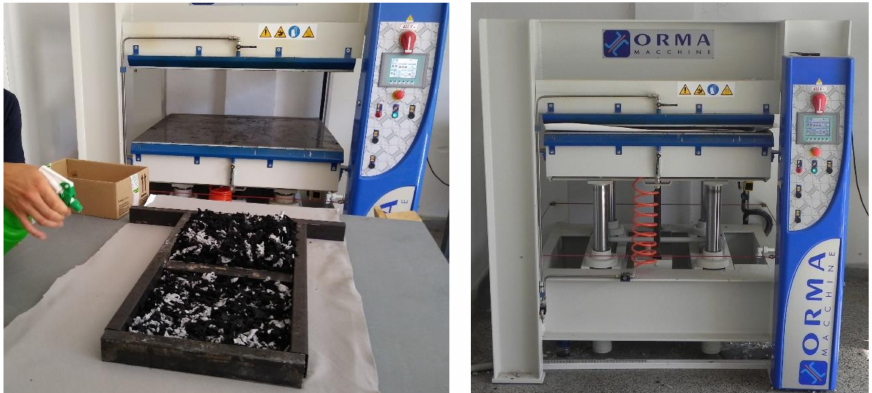
Figure 3. Applying of water glass on the shredded waste nonwoven textile ( left ) and pressing of the prepared material in the preheated hydraulic press ( right ).